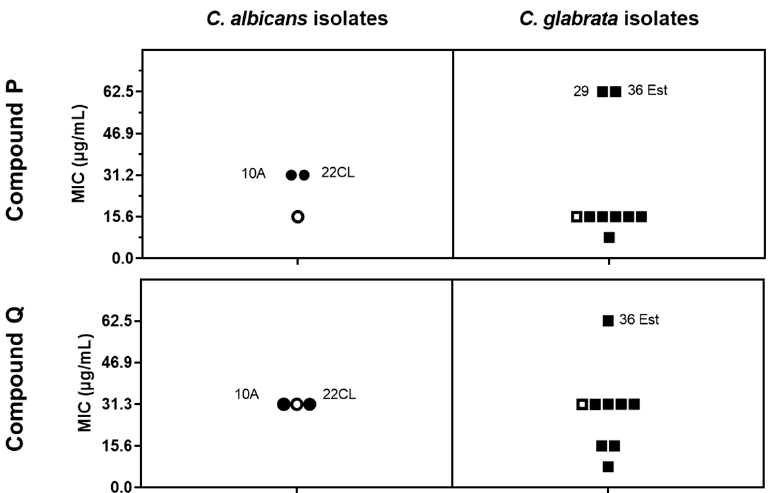
Figure 1. MIC values ( µ g/mL) of the complexes P and Q, obtained for laboratory strains C. albicans SC5314 and C. glabrata CBS138 (open symbols) and a set of azole-resistant clinical strains (closed symbols) (Table 1). The shown MICs represent the concentration of the compounds required to inhibit the growth of the strains in 50%, compared to the growth registered in a drug-free medium which was used as a control.